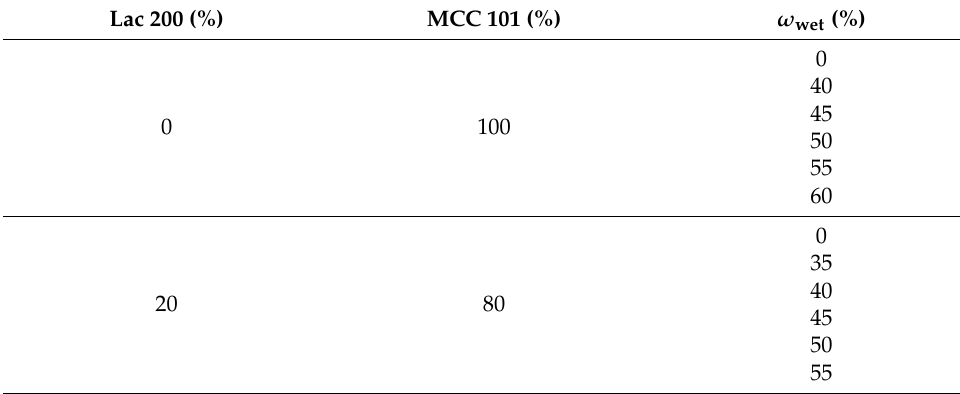
Table A1. Raw data corresponding to Table 2 and Figure 2. The ratios of the raw materials Lac 200 and MCC 101 refer to the total dry mass, whereas the water content ω wet refers to the total wet